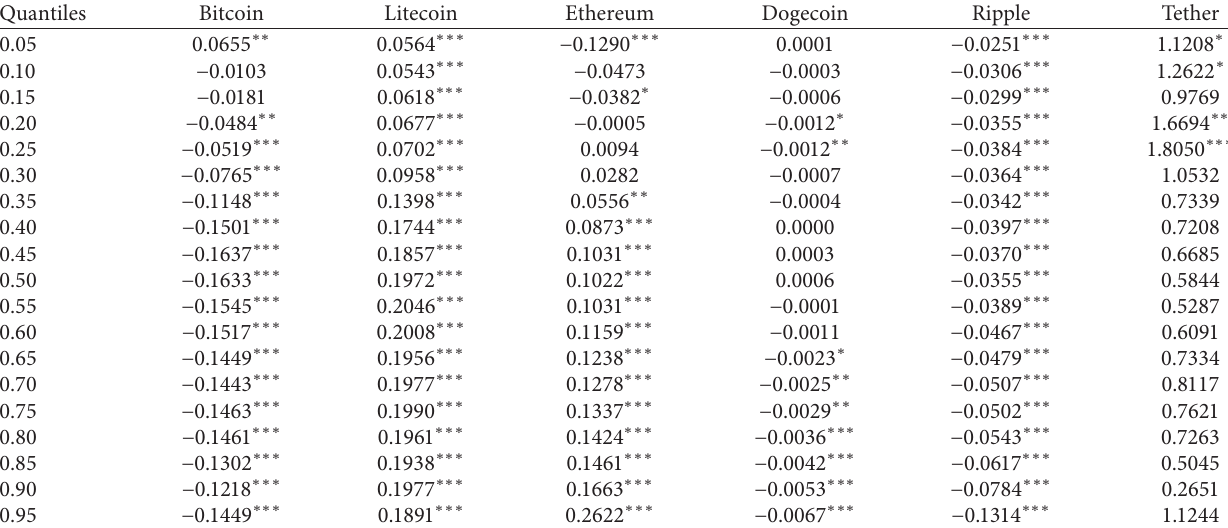
Table 4: Quantile regression results of